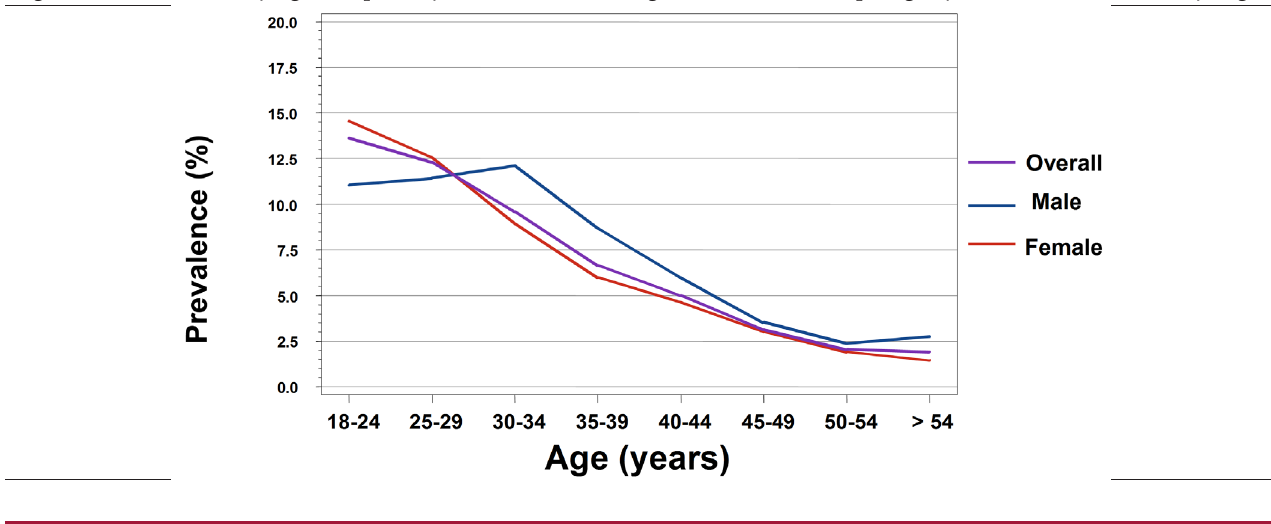
Figure 1. GW Prevalence by Age Group and by Gender for Patients Age 18–60 Years (Participating Physicians for Two-Week Daily Log)